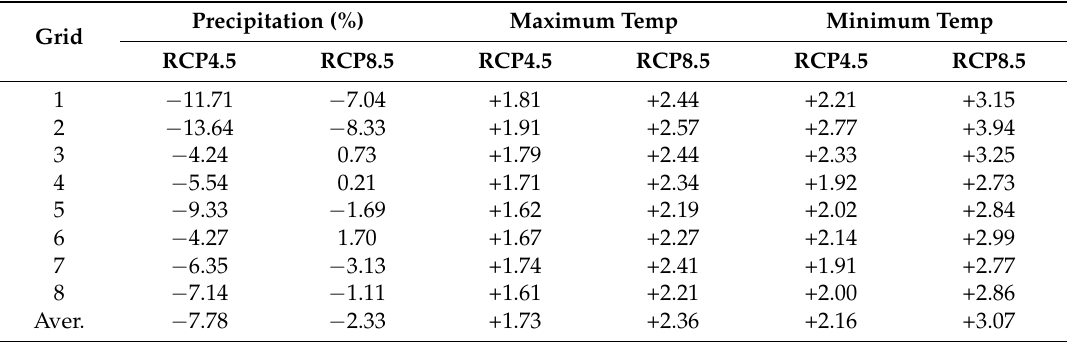
Table 1. Change in climate data in scenario period as compared to the historical period.